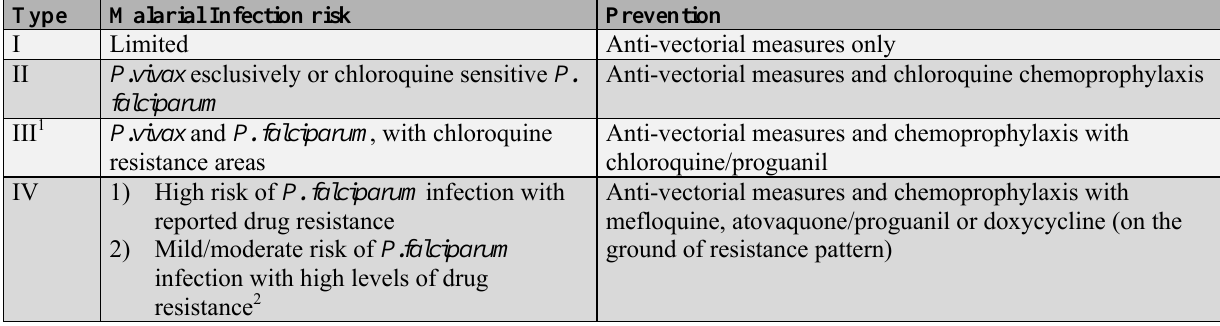
Table 4. Prophylaxis by area (reference [90],